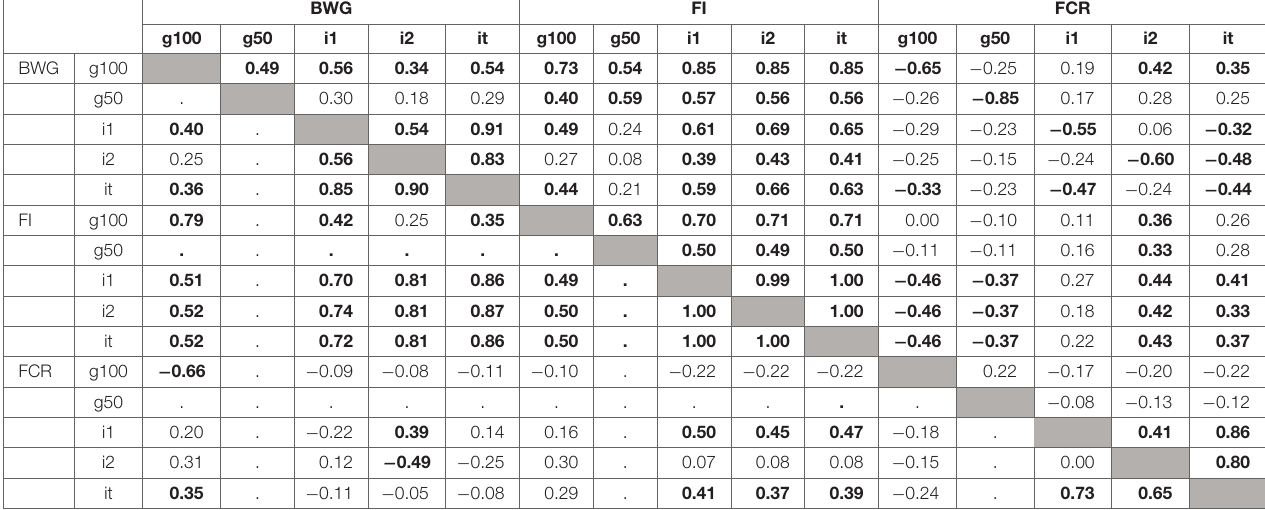
TABLE 2 | Phenotypic correlation between all the measured traits. BWG FI